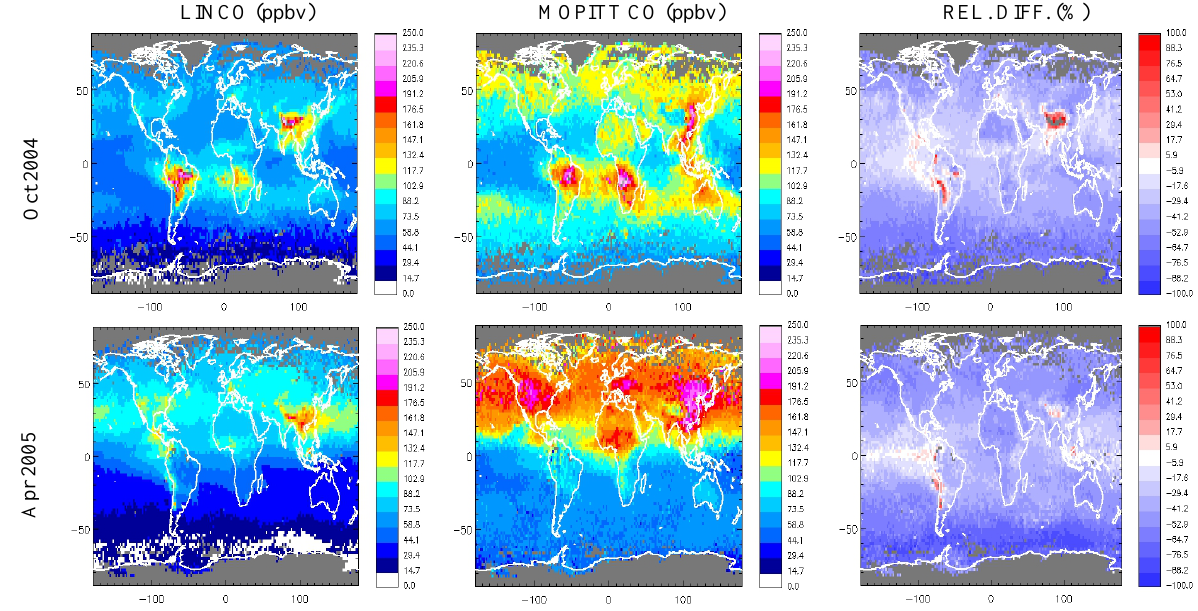
Fig. 5. CO fields in parts per billion by volume (ppbv) at 700hPa calculated by LINCO smoothed by MOPITT averaging kernels (left), MOPITT CO (ppbv) (middle) and corresponding relative differences (%) (Model-Obs)/Obs x100 in October 2004 (upper panels) and April 2005 (lower panels).